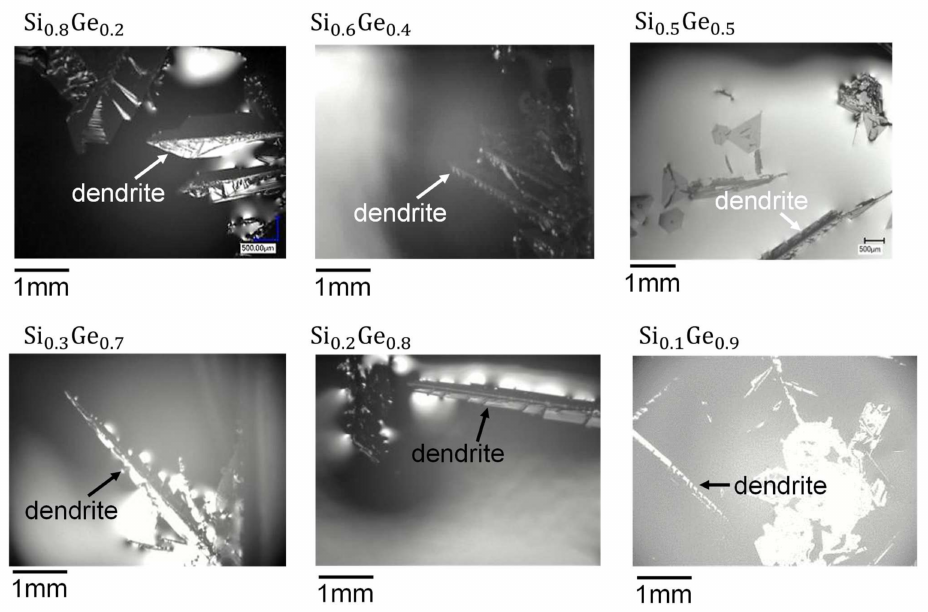
Figure 4. Growth shape of dendrites in Si 1 − x Ge x (0 < x < 1) melts with various